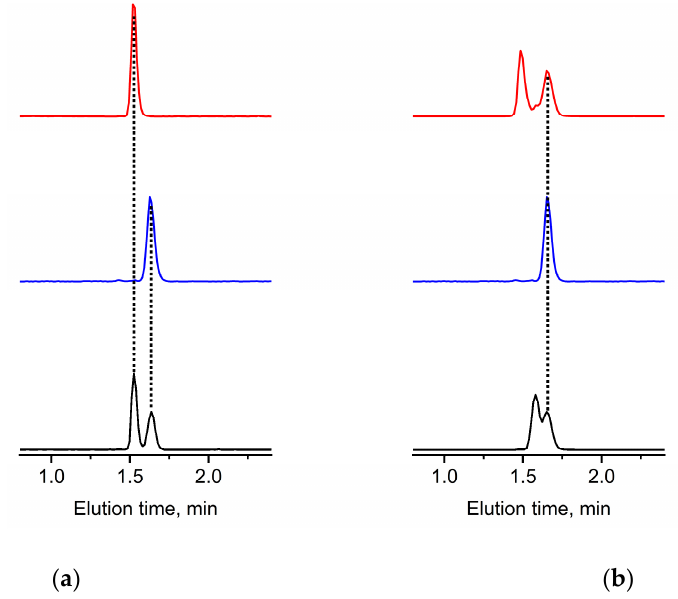
Figure 3. ( a ) PEGdiol ( M n = 1,840 g mol − 1 , red trace), mPEG ( M n = 2,300 g mol − 1 , blue trace), and their respective 50/50 (%, v / v ) mixtures (black trace) and ( b ) mPEG ( M n = 2,300 g mol − 1 , blue trace) together with M n = 375 g mol − 1 PEGdiol in a respective 50/50 (%, v / v ) mixture (red trace), and M n = 2,800 g mol − 1 PEGdiol in a respective 50/50 (%, v / v ) mixture (black trace). Mobile phase flow rate of 1 mL min − 1 and mobile phase composition of 40/60 acetonitrile/water (%, v / v ).